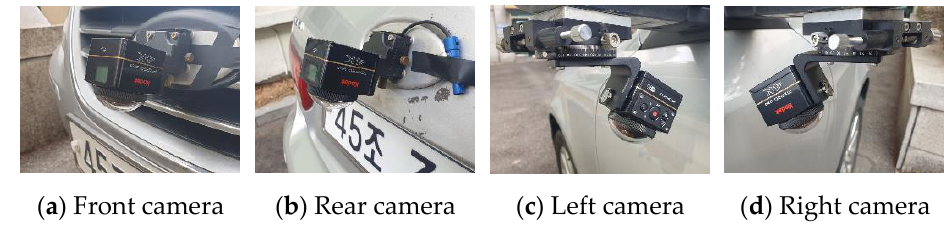
Figure 9. Four installed cameras for the field experiments.